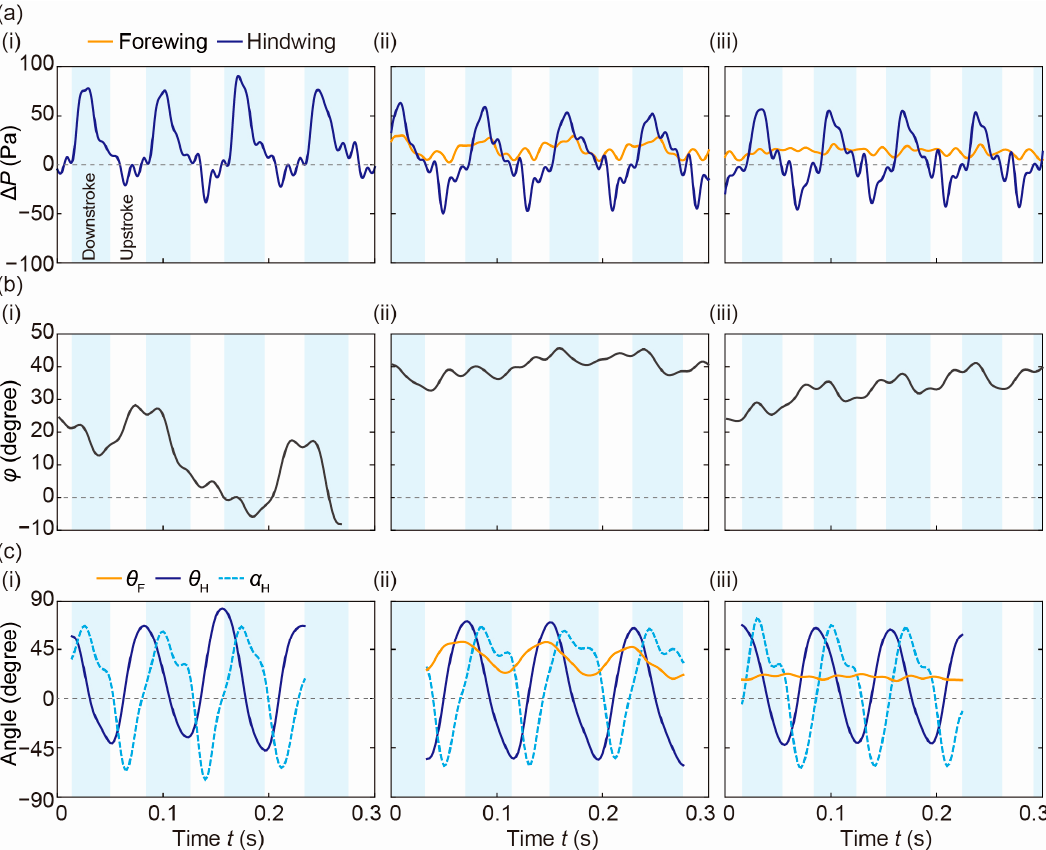
Figure 6. ( a ) Differential pressures at the center of the forewing and hindwing of the ornithopter ( i ) without a forewing ( ii ) with a flapping forewing and ( iii ) with a fixed forewing; ( b ) Calculated value of the body angle φ ; ( c ) Calculated values of the flapping angle θ F , θ H and feathering angle α H of the ornithopters.